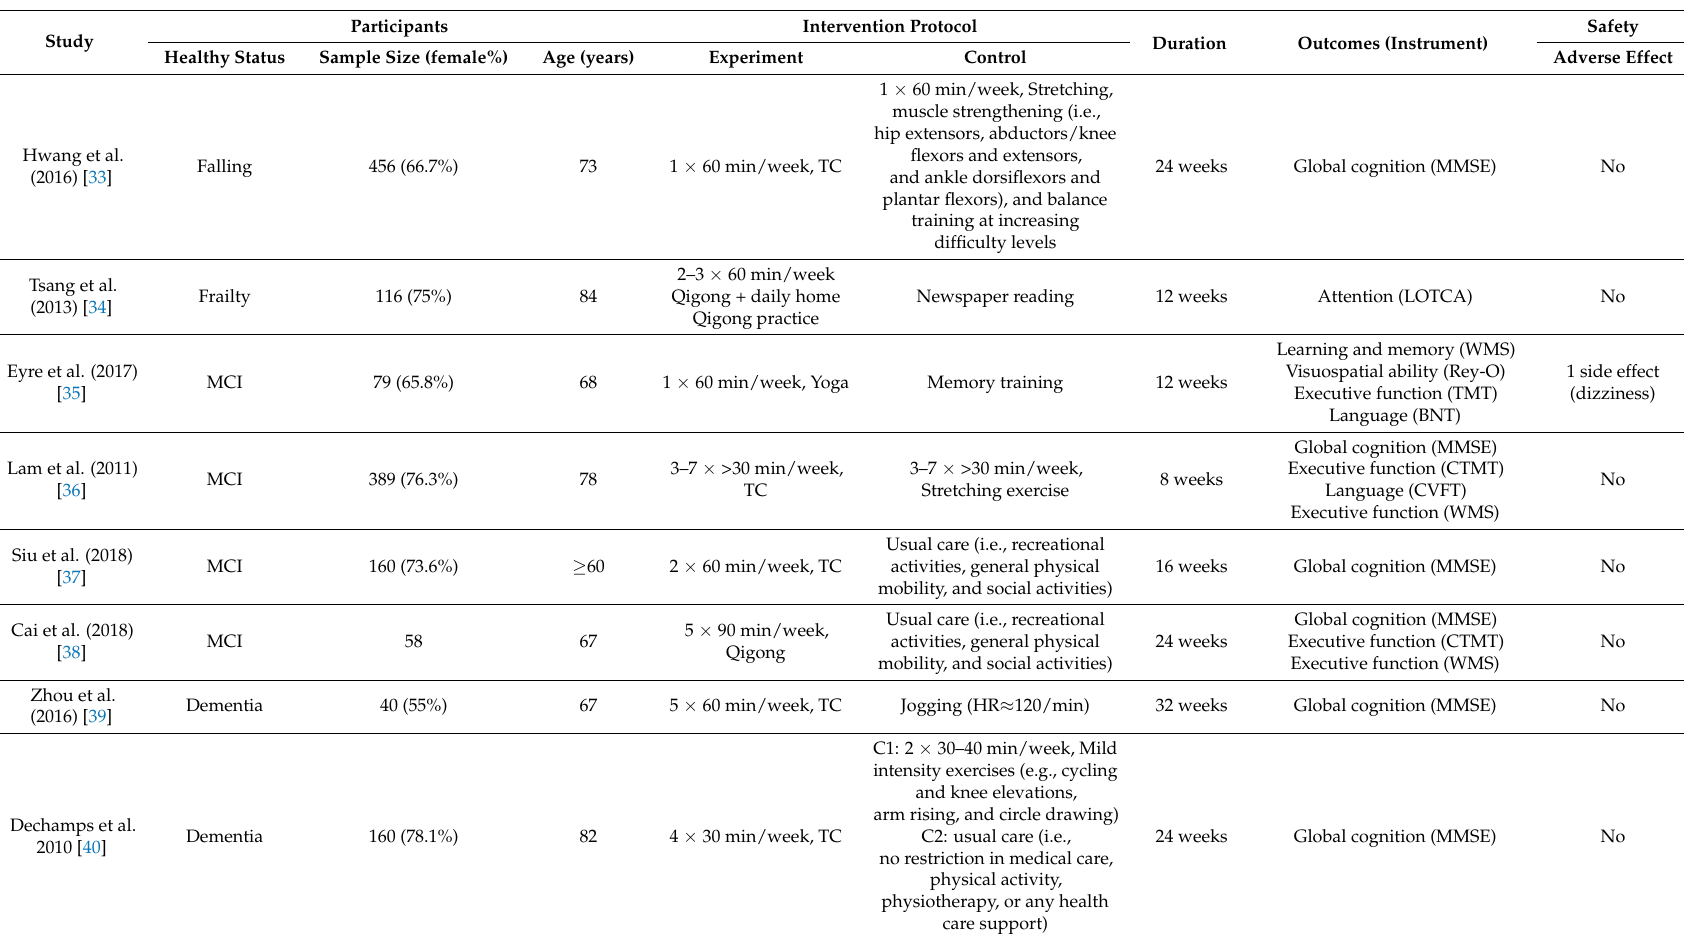
C1: 2 × 30–40 min/week, Mild intensity exercises (e.g., cycling and knee elevations, arm rising, and circle